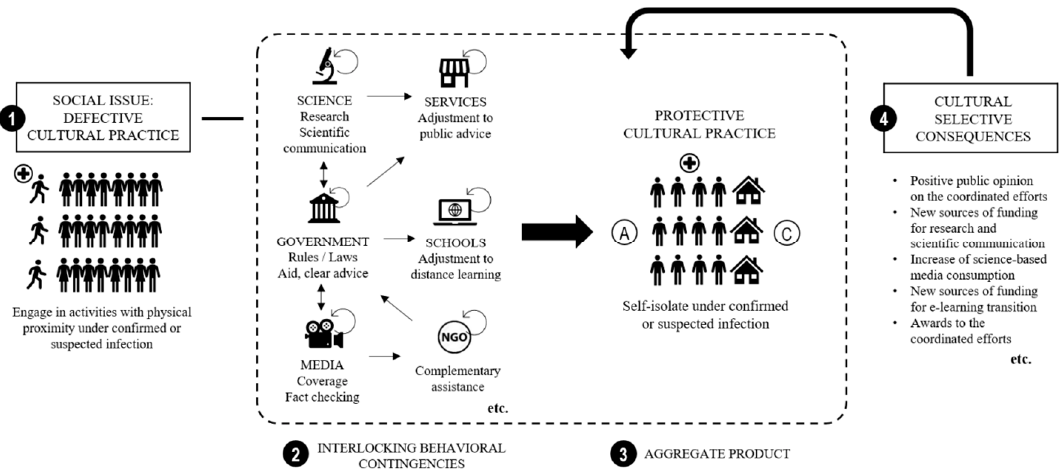
Figure 3. Metacontingency of support illustrating how defective practices ( 1 ) may require agencies’ coordination ( 2 ) in order to enhance population engagement in protective behaviors ( 3 ). Note: A = antecedent events; C =